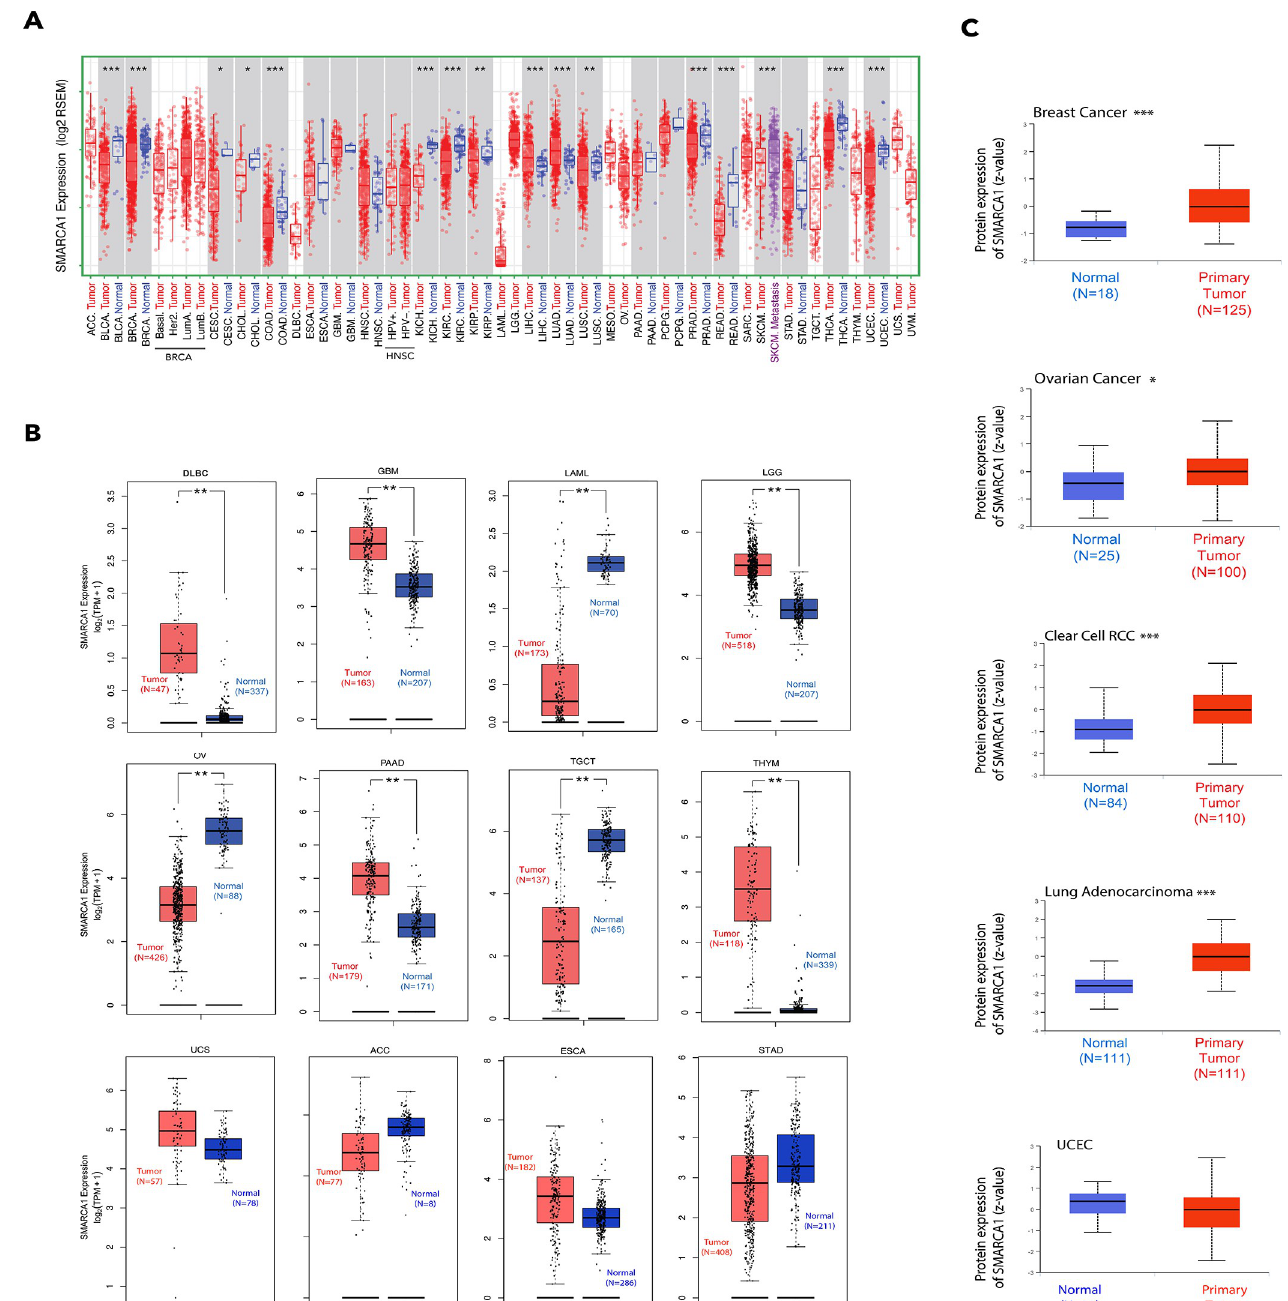
Fig 2. Comparison of SMARCA1 expression level in different tumor and adjacent normal tissues. (A) Analysis of SMARCA1 expression level in different tumors or their subtypes and corresponding normal tissues via TIMER2. � P < 0.05, �� P < 0.01, ��� P < 0.001. (B) By including the relevant normal tissues of the GTEx database as controls, the SMARCA1 Expression status in ACC, DLBC, GBM, ESCA, LAML, LGG, OV, PAAD, STAD, TGCT, THYM and UCS were analyzed via GEPIA2. �� P < 0.01. (C) Analysis of SMARCA1 expression in total protein between primary tumor and normal tissues of five cancers based on the CPTAC dataset. � P < 0.05, �� P < 0.01, ��� P < 0.001.